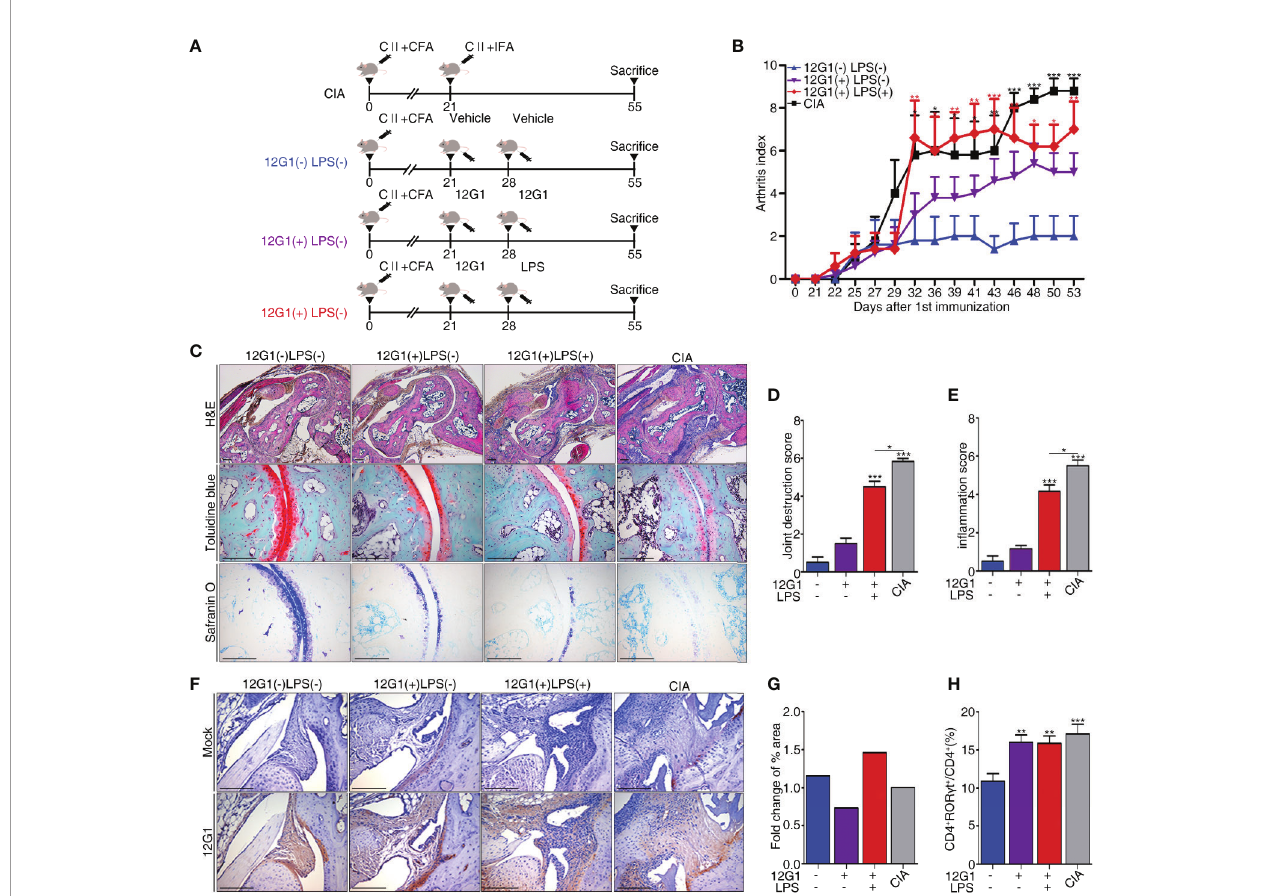
FIGURE 4 | A new animal model using 12G1 mAb was constructed, and its function was con fi rmed by comparison with the collagen induced arthritis (CIA) model. (A) Schematic diagram of the CIA animal model (a standard model of rheumatoid arthritis) and the animal model using the aACPA. (B) Average arthritis scores for the animal models. This score is expressed on a scale of 0 – 4 as the sum of the arthritis severity scores for the four paws of each animal. (C) Histological analysis of the tarsals in the hind paws of each group stained with hematoxylin and eosin (H&E), safranin O, and toluidine blue. H&E-stained sections were magni fi ed 50x and 100x; safranin O and toluidine blue samples are shown at 200x magni fi cation. Histological scores were calculated as joint destruction scores (D) and in fl ammation scores (E) by three observers in a blind manner. (F) Immunohistochemical (IHC) staining of citrullinated proteins in the tarsals, magni fi ed 100x. (G) Measurement of the 12G1 mAb positive cell area per whole tarsal joint area by the Slide scanner program (3D Histech Ltd, Budapest, Hungary). (H) Flow cytometry analysis of the CD4 and ROR g t expression in the spleens of each group. The percentages of CD4+ ROR g t+ divided by total CD4+ indicate the frequency of Th17 cells. All scale bars are 200µm, and all graphs are expressed using the mean ± SEM. * P < 0.05; ** P < 0.01; *** P <